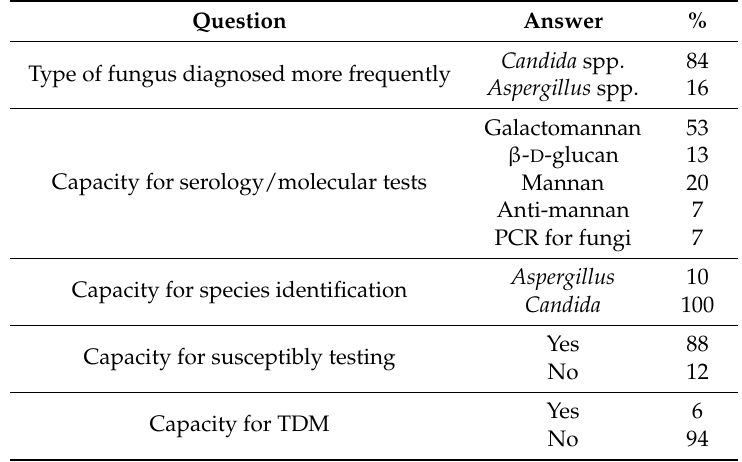
Table 3. Diagnostic capacity for IFIs in 17 laboratories of participating Greek hospitals. Question Answer % Candida spp. 84 Type of fungus diagnosed more frequently Aspergillus spp. 16 β - D